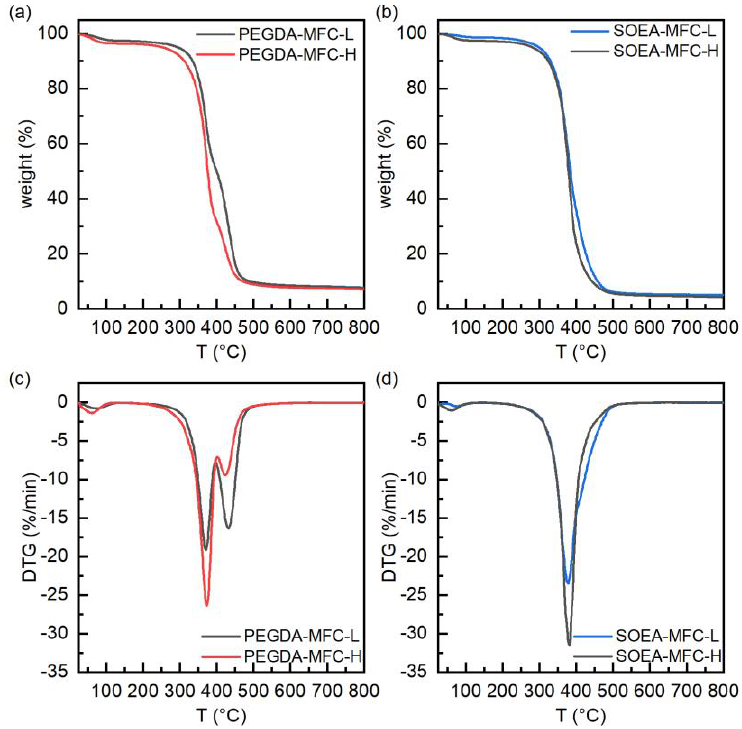
Figure 7. TGA weight and first derivative curves for ( a , c ) PEGDA-based composites and ( b , d ) SOEA-based composites. Table 2. Tensile properties of PEGDA-based and SOEA-based composites with different compositions: Young’s modulus, E, and tensile strength, σ